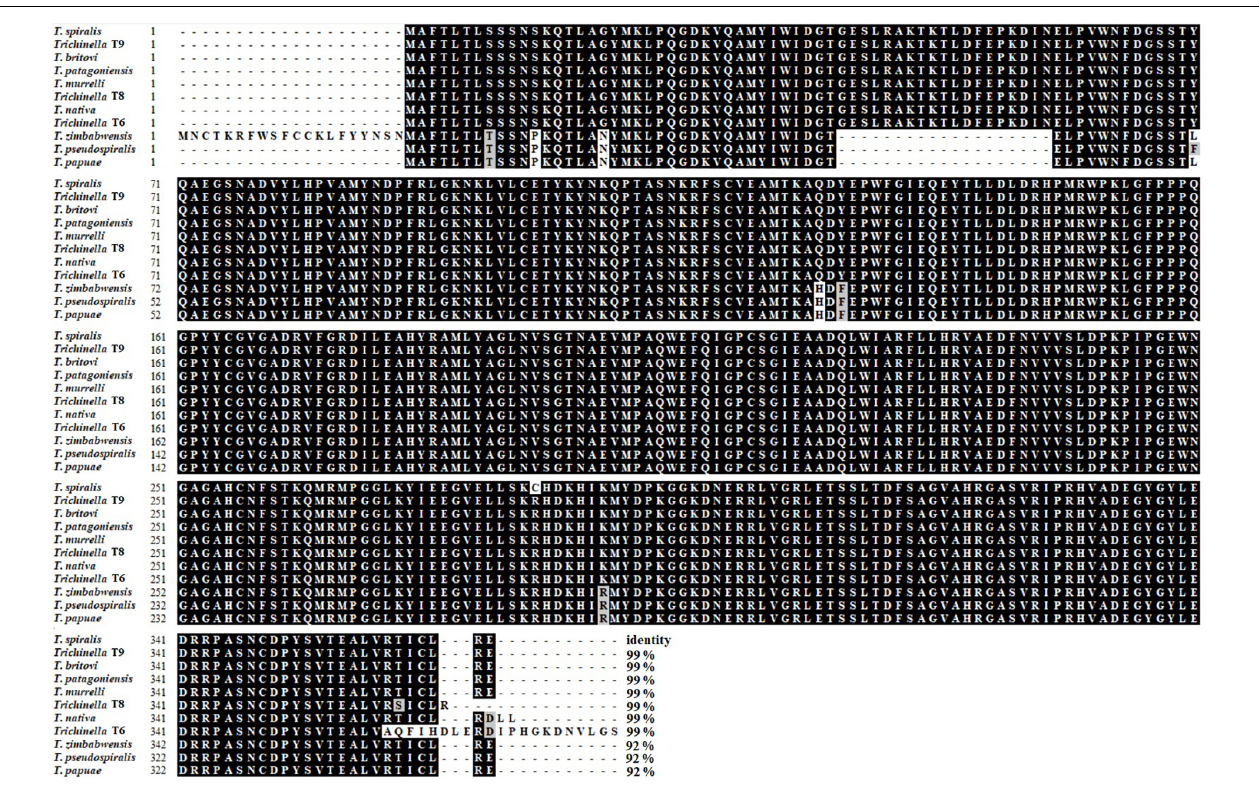
FIGURE 1 | Sequence alignment of TsGS with other species or genotypes of the genus Trichinella . Multiple sequence alignment was carried out by using BioEdit, the black shadow represents the same residue as TsGS, and the gray shadow is a conservative substituent. The number at the end of each sequence represents the percentage of identity with